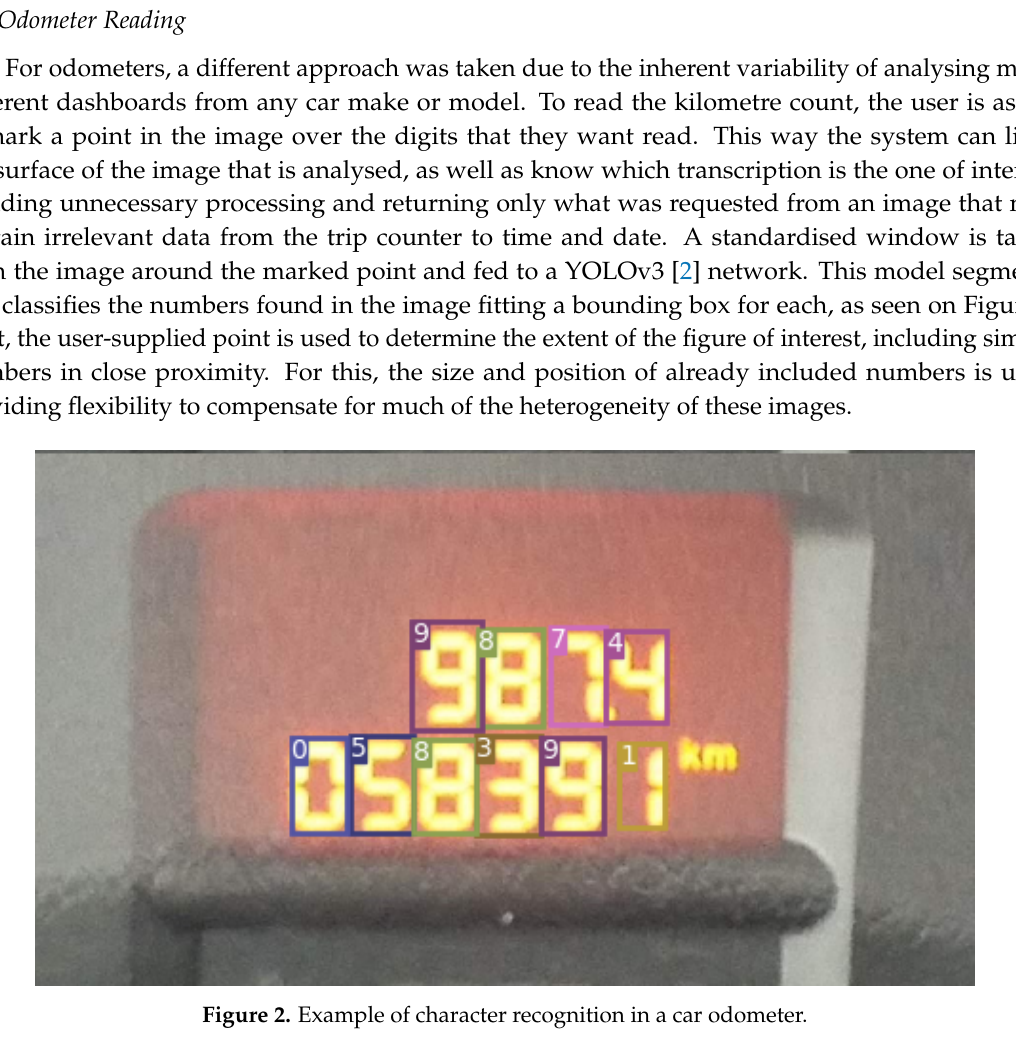
Figure 1. Summary of the license plate reading procedure: ( left ) Original image. ( center ) Segmentation and perspective estimation. ( right ) Cleaning, thresholding and single character segmentation.